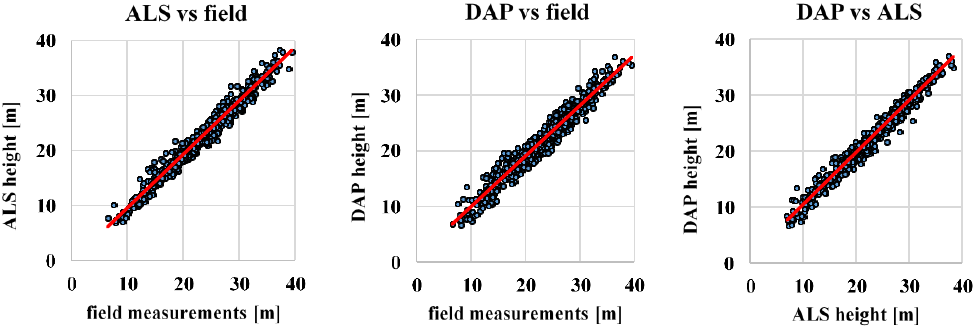
Figure 3. The correspondence between the tree heights derived from ALS, DAP and field measurements.